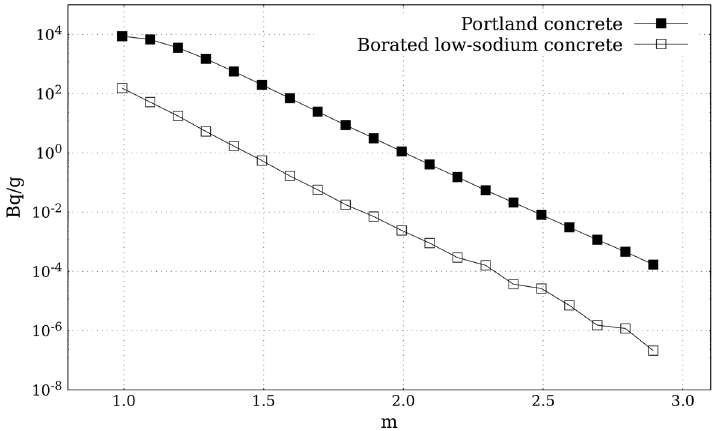
Figure 8. Decline in 24 Na specific activity in Portland concrete and borated low ‐ sodium concrete throughout the top shielding. throughout the top